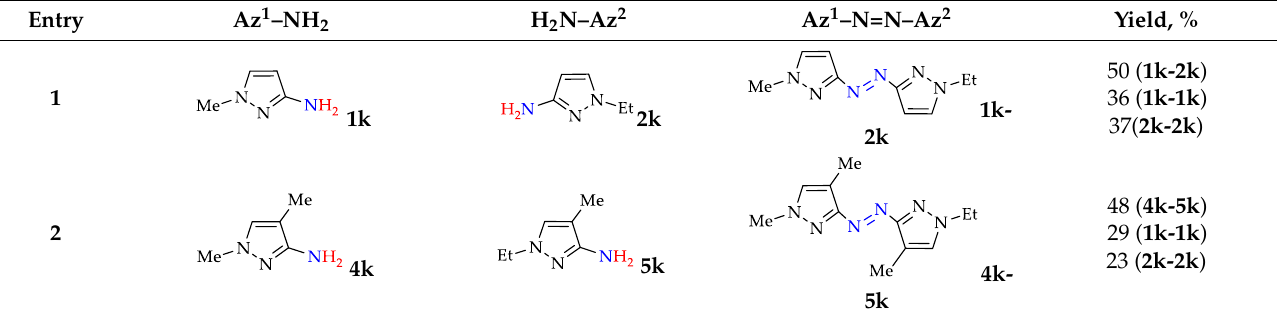
Table 7. N–N cross-coupling of aminopyrazoles (Az–NH 2 ) using approach A 1 . Table 7. N – N cross-coupling of aminopyrazoles (Az – NH 2 ) using approach A 1 . Table 7. N – N cross-coupling of aminopyrazoles (Az – NH 2 ) using approach A 1 . Table 7. N – N cross-coupling of aminopyrazoles (Az – NH 2 ) using approach A 1 . Table 7. N – N cross-coupling of aminopyrazoles (Az – NH 2 ) using approach A 1 . Table 7. N – N cross-coupling of aminopyrazoles (Az – NH 2 ) using approach A 1 . Table 7. N – N cross-coupling of aminopyrazoles (Az – NH 2 ) using approach A 1 . Entry